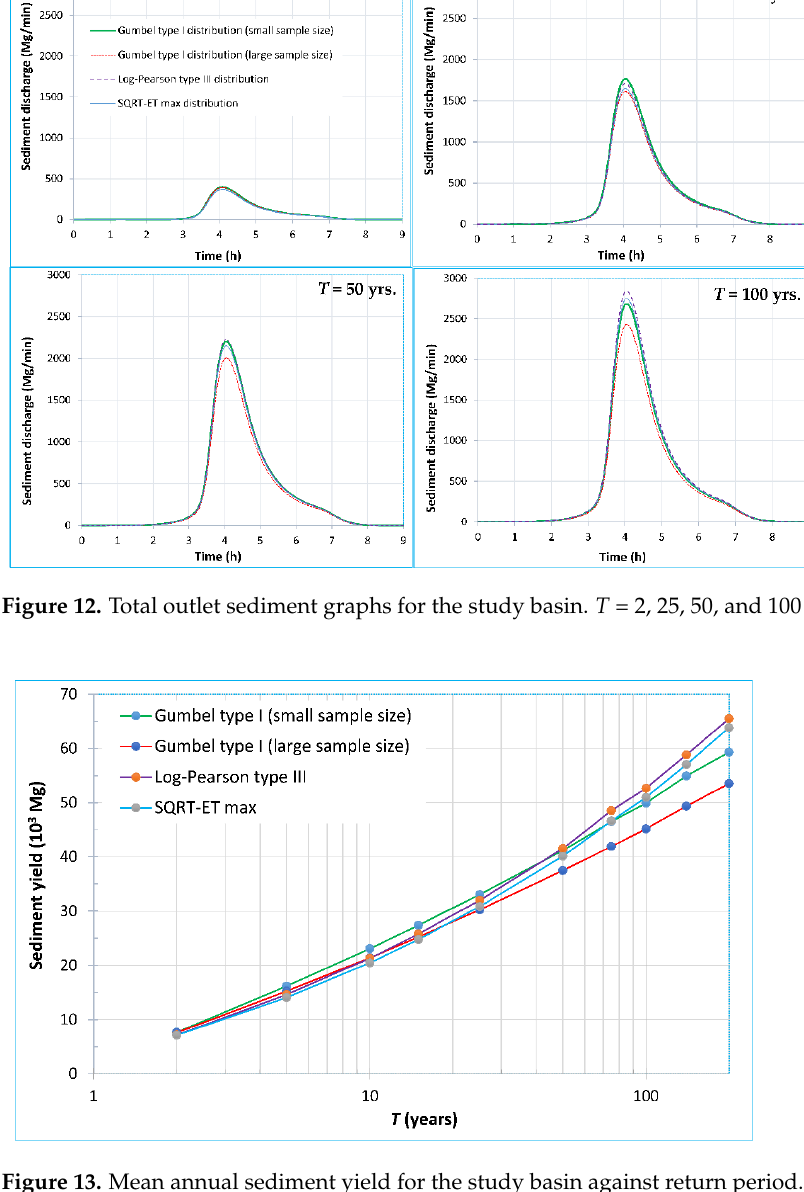
Table 5. Mean annual sediment yield estimation and comparative analysis.